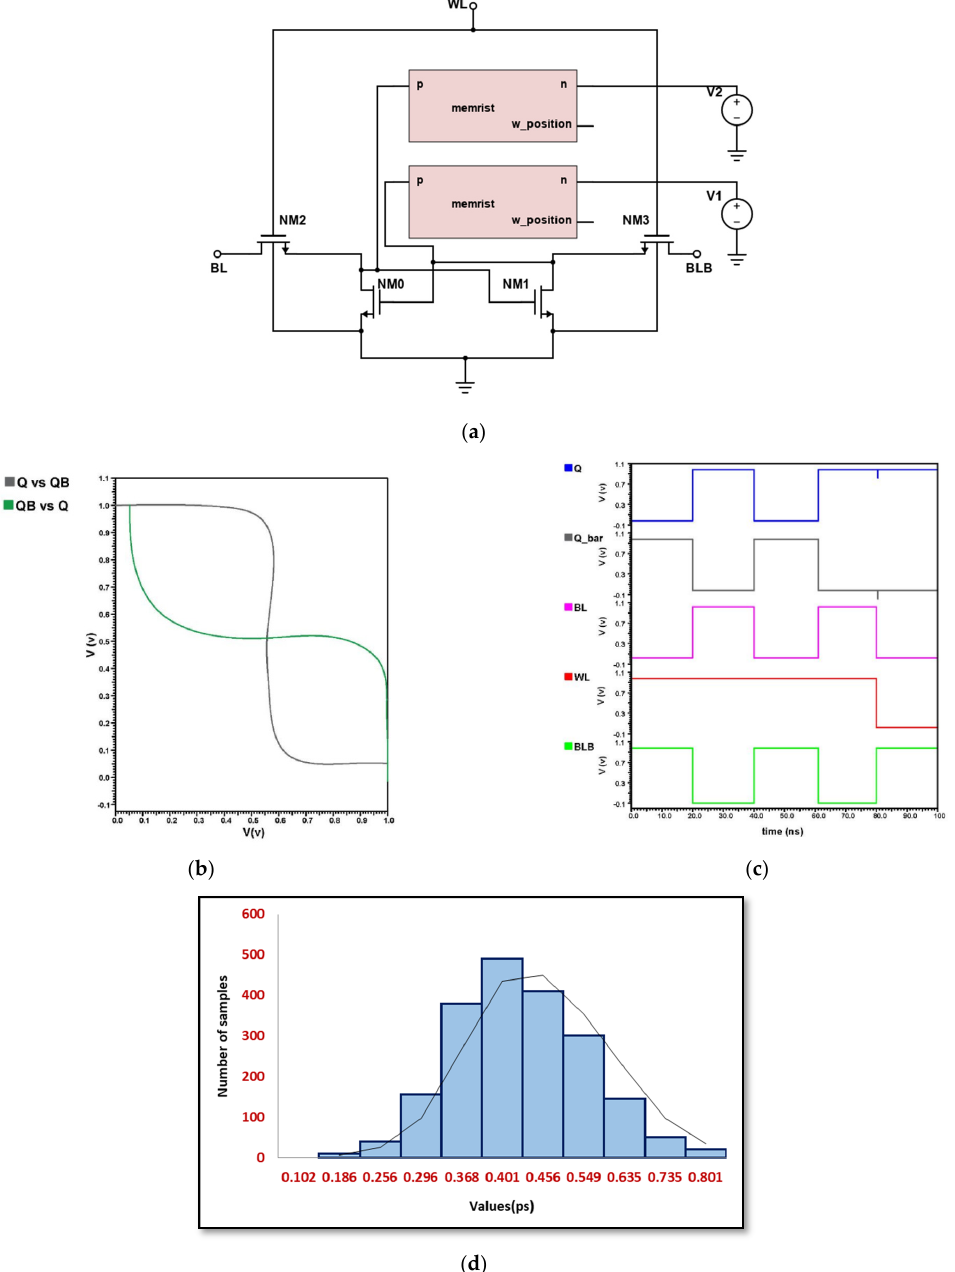
Figure 10. Hybrid MOS–Memristor 6T-SRAM design ( a ) Schematic, ( b ) DC Analysis, ( c ) Transient Analysis, and ( d ) Monte Carlo Simulation .